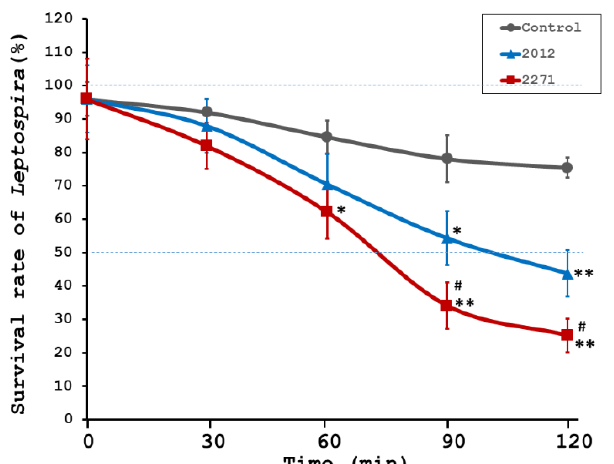
Figure 2. Anti-LRR protein bactericidal proficiency. The serum bactericidal assays to measure Leptospira survival rates were used to assess the in vitro bactericidal efficiency of sera bled from each animal in experiment 1 ( n = 8 per each treatment) 3 weeks after the 2nd immunization before the challenge. Hamster sera from control (gray line), either rhKU_Sej_LRR_2012 (2012; blue line) or rhKU_Sej_LRR_2271 (2271; red line) immunized animals ( n = 8 per group in experiment 1) were incubated with low passage, highly virulent L. interrogans serovar Pomona at 37 °C, and the viability of the bacteria was observed using dark-field microscopy at different time points (0, 30 60, 90 and 120 min) of incubation. Each value represents the mean ± S.E.M. Data were compared between animals immunized with 2012 protein, 2271 protein, and control groups with statistically significant differences at a p -value < 0 . 05 (*) and <0.01 (**), respectively, and were compared between 2012 and 2271 vaccinated groups as a p- value < 0 . 05 (#) .